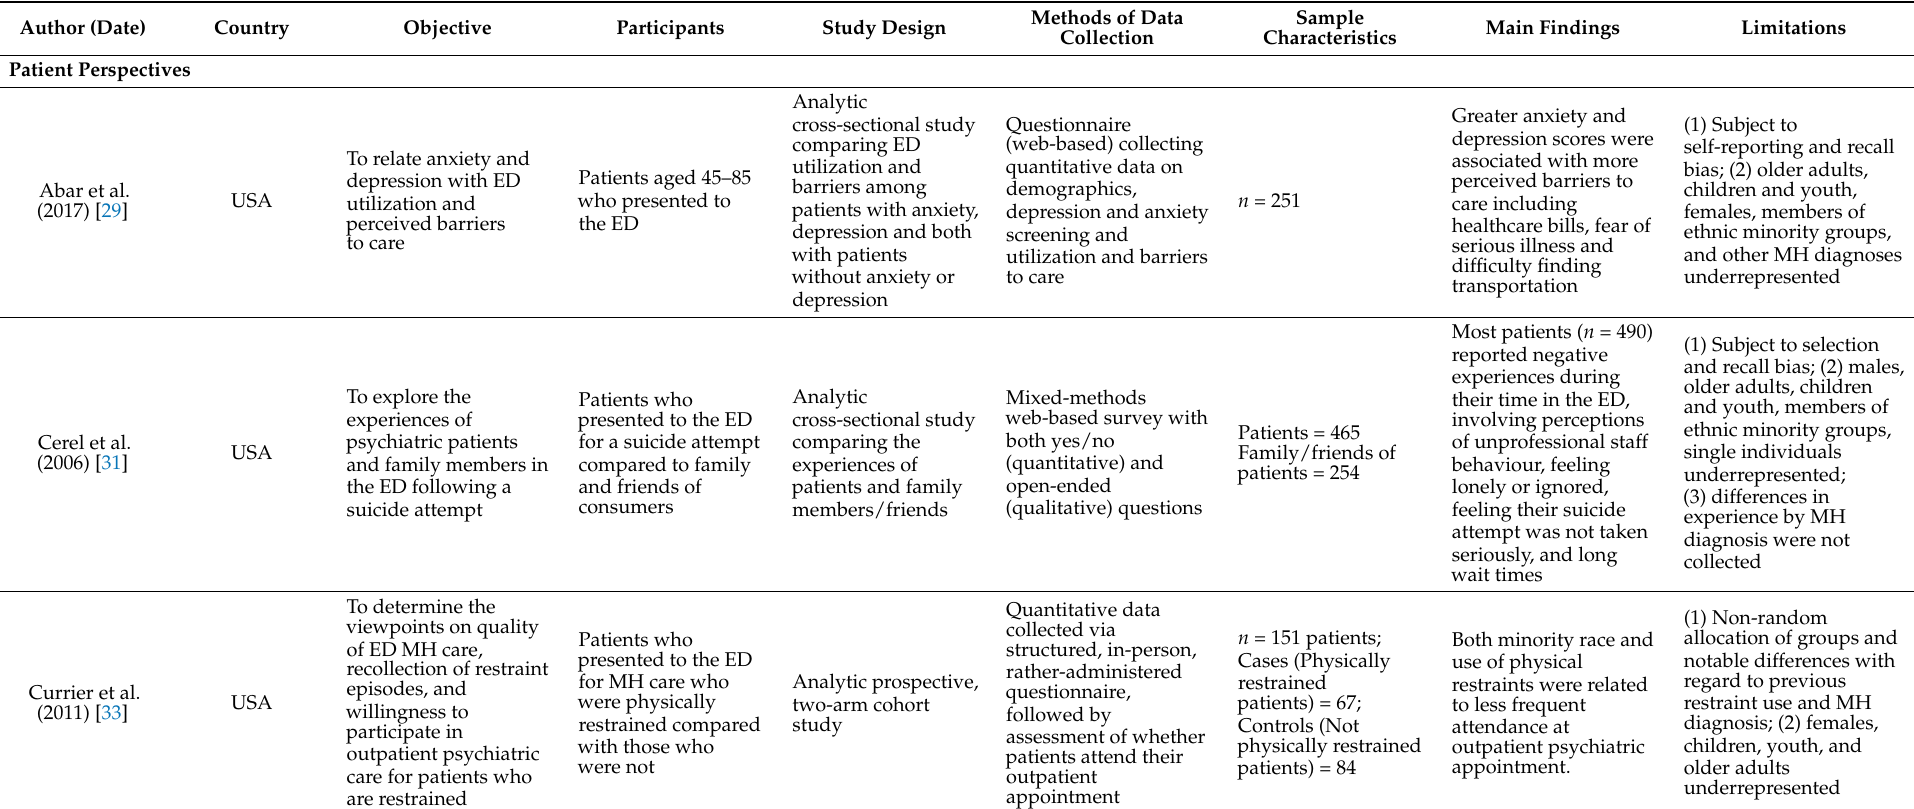
Table 1. Critical appraisal and quality assessment of articles included in paper ( n =